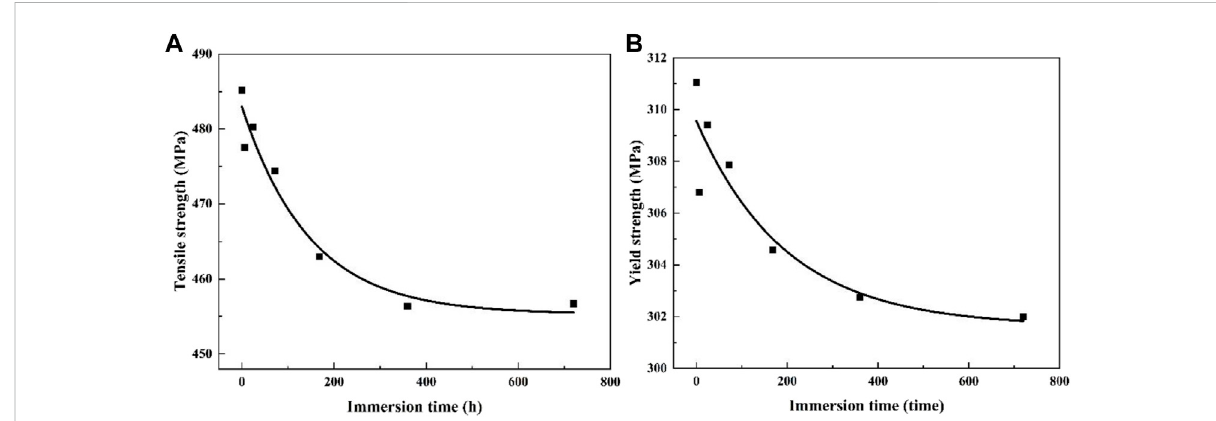
FIGURE 8 The trend of mechanical properties of 2060-T4 Al-Li alloy with immersion time and its fi tting curve, (A) tensile strength, (B) yield strength.